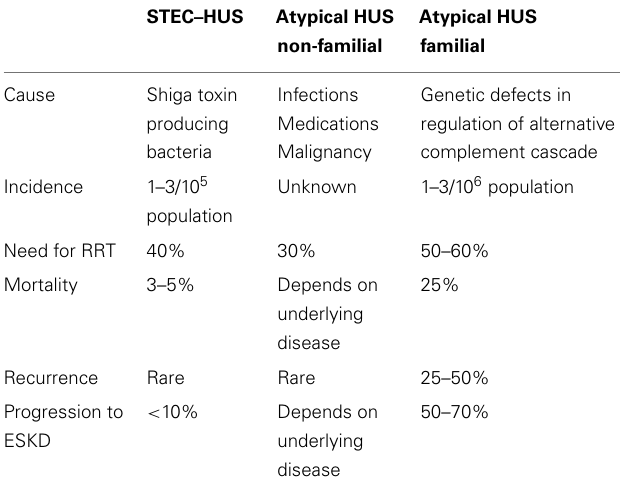
Table 1 | Clinical taxonomy of HUS